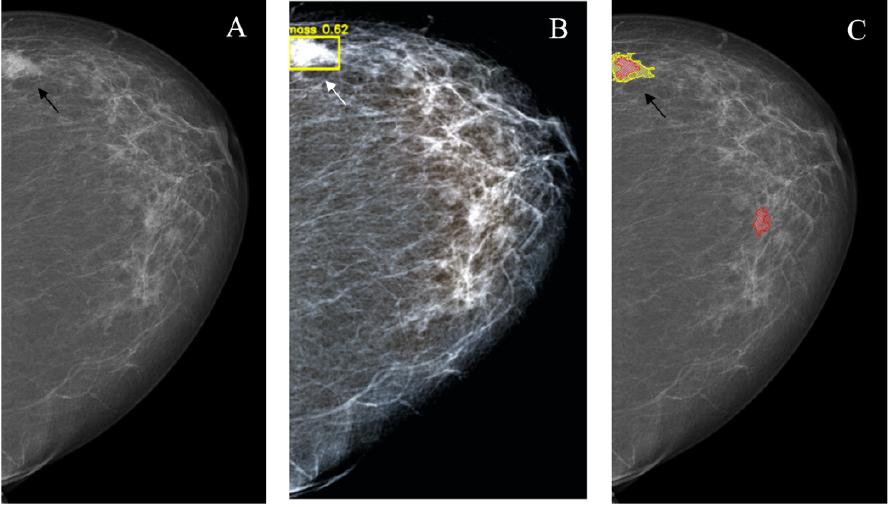
Figure 7. Partly visualized mass (arrow). ( A ): Source image; ( B ): YOLOv4 outcome; ( C ): NCA out ‐